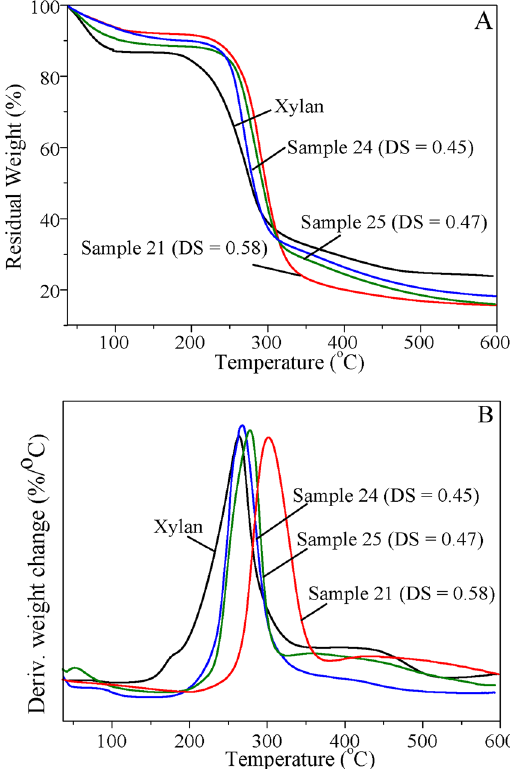
Figure 6. TGA ( A ) and DTG ( B ) curves of xylan and xylan- g -PLA copolymers samples 21 (DS = 0.58), 24 (DS = 0.45) and 25 (DS = 0.47).